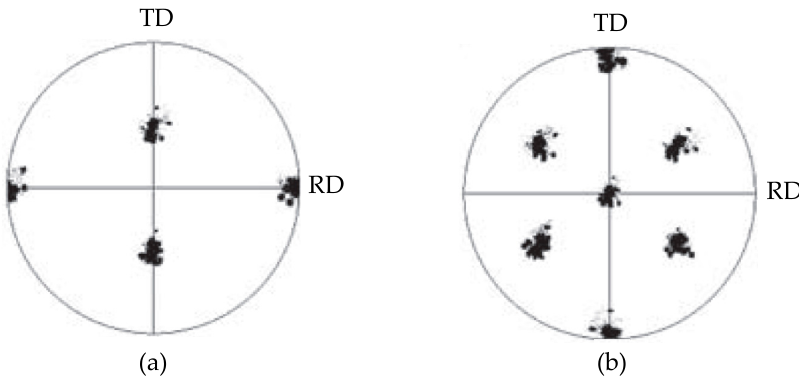
Figure 3. Pole figures measured in a GOES sample with Goss texture, presented in the paper [6] (p. 617). ( a ) Crystallographic plane (001), ( b ) crystallographic plane (011).